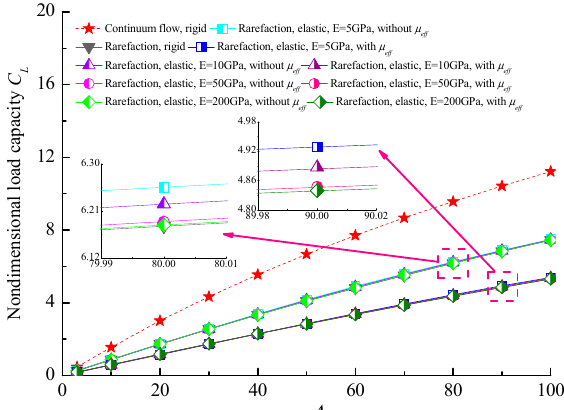
Figure 7. E ff ect of bearing number on the non-dimensional load capacity for di ff erent elastic moduli Figure 7. Effect of bearing number on the non-dimensional load capacity for different elastic moduli with and without effective viscosity ( ε = 0.7, υ = 0.3). with and without e ff ective viscosity ( ε = 0.7, υ =